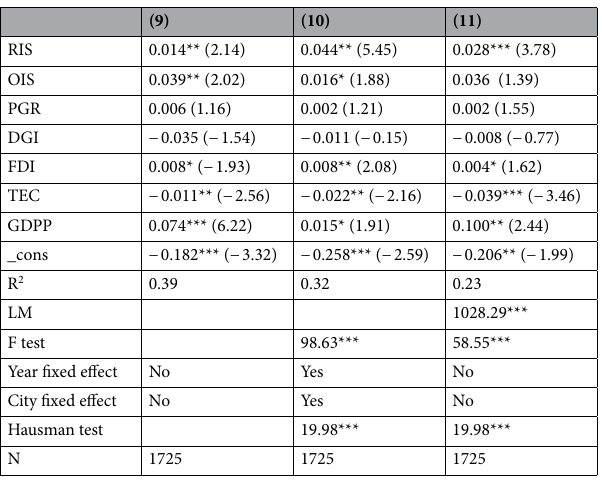
1725 1725 1725 Table 4. Robustness test results. * p < 0.1, ** p < 0.05, *** p < 0.01; the bracket represents the t value.